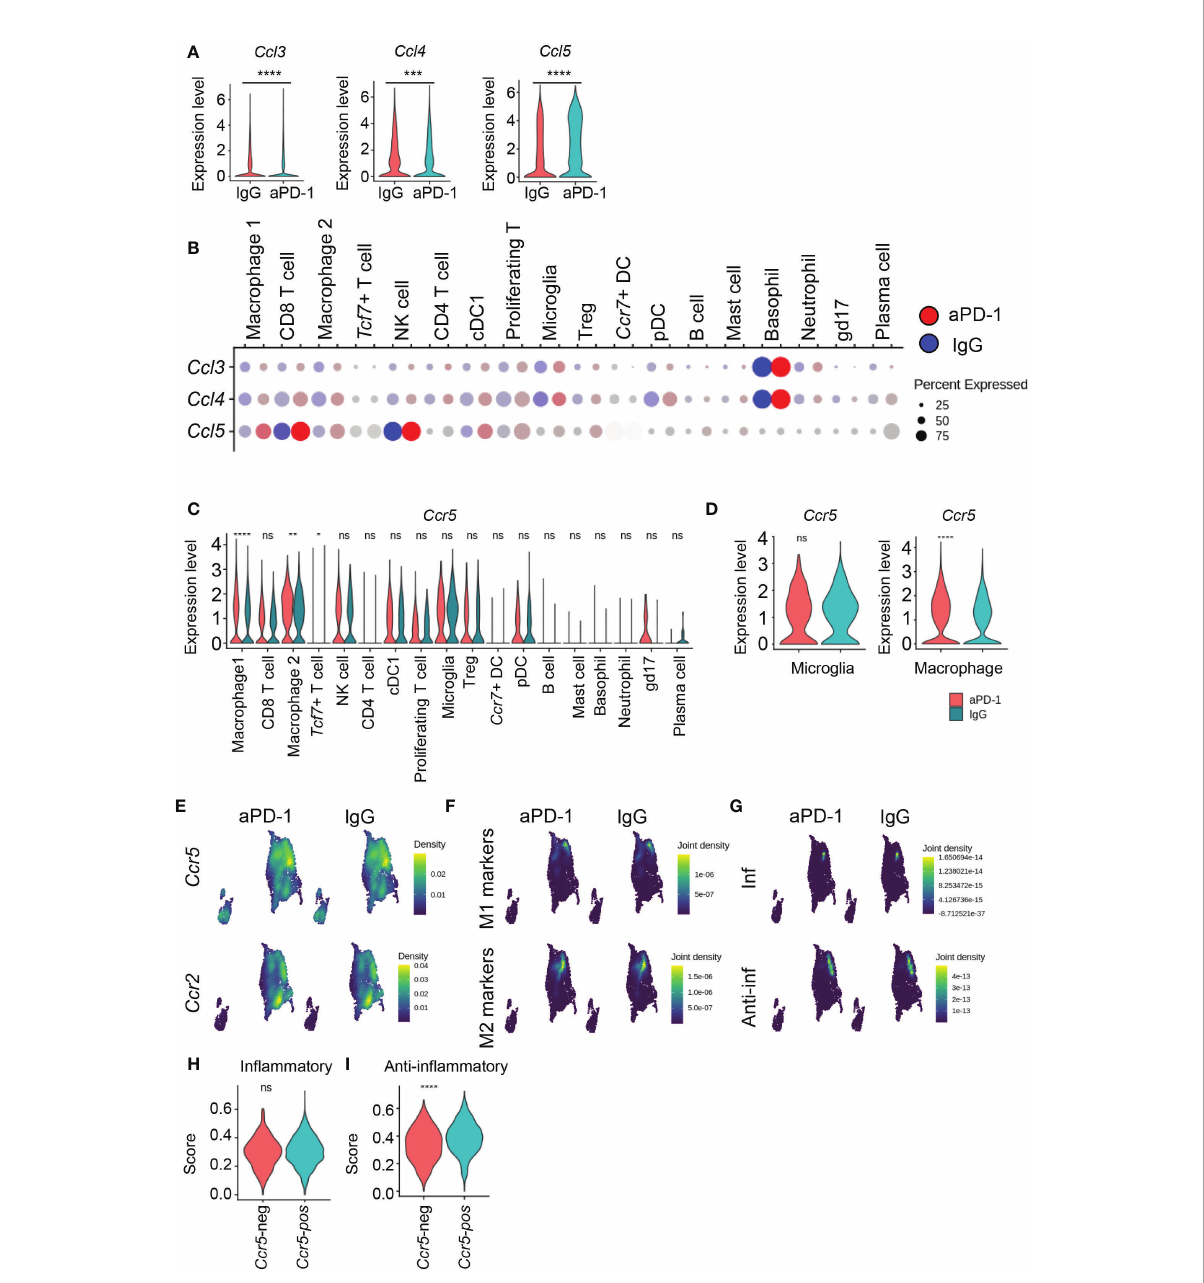
FIGURE 6 aPD-1-induced Ccl5 recruits Ccr5 + anti-in fl ammatory macrophages. (A) The expression of Ccl3 , Ccl4 , and Ccl5 from whole immune cells from IgG-treated and aPD-1-treated groups. (B) Expression of Ccl3 , Ccl4 , and Ccl5 in different immune cells of IgG-treated or aPD-1-treated groups. (C, D) Expression of Ccr5 in different immune cells (C) and microglia and macrophages (D) . (E) The expression density of Ccr5 and Ccr2 from IgG-treated or aPD-1-treated macrophages/microglia. (F) The expression density of M1 markers ( Nos2 , Itgax , Cd80 , Cd86 ) and M2 markers ( Tgfb1 , Il10 , Arg1 , Mrc1 ) from IgG-treated or aPD-1-treated macrophages/microglia. (G) The expression density of in fl ammatory ( Cd86 , Cd80 , Cxcl10 , H2-Ab1 , Il1b , Tlr2 , Tnf , Il6 , Il12a , Nos2 , H2-DMb2 ) and anti-in fl ammatory ( Tnfbi , Il1rn , Il10rb , Cd274 , Il4ra , Msr1 , Tgfb1 , Il6st ) genes from IgG-treated or aPD-1-treated macrophages/microglia. (H, I) The expression of in fl ammatory (H) and anti-in fl ammatory (I) genes in Ccr5- negative or Ccr5- positive macrophages. Data were analyzed by the stat_compare_means function with unpaired t-test. * P <0.05, ** P <0.01, *** P <0.001, **** P <0.0001. ns, not signi fi